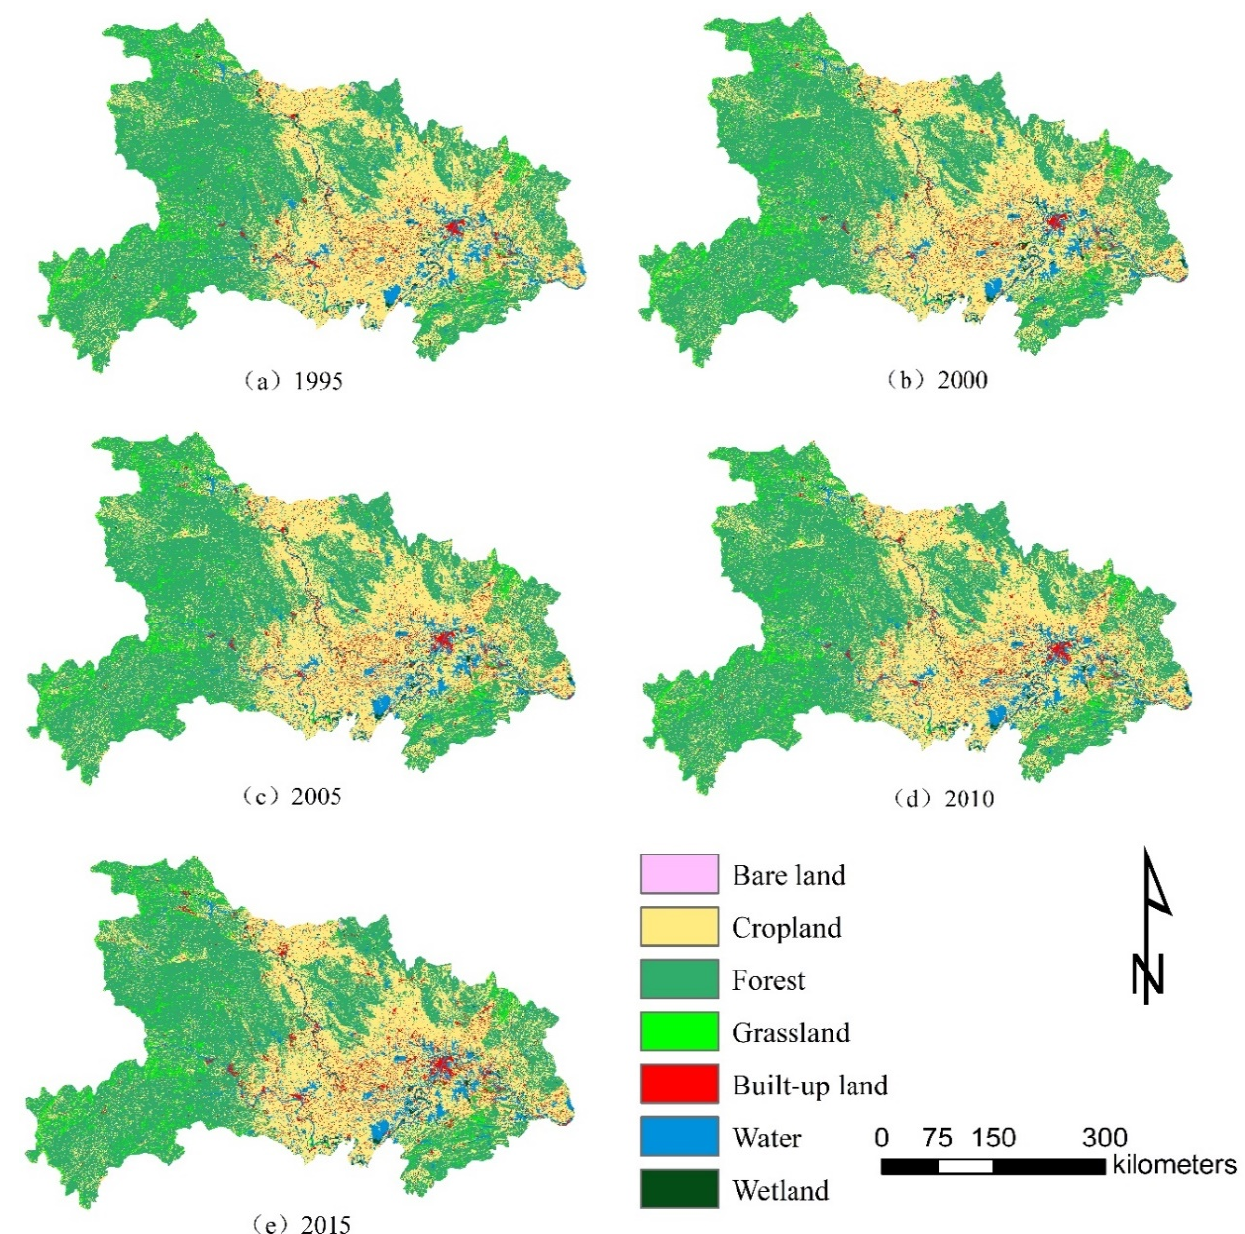
Figure 2. Land use change from 1995 to 2015.